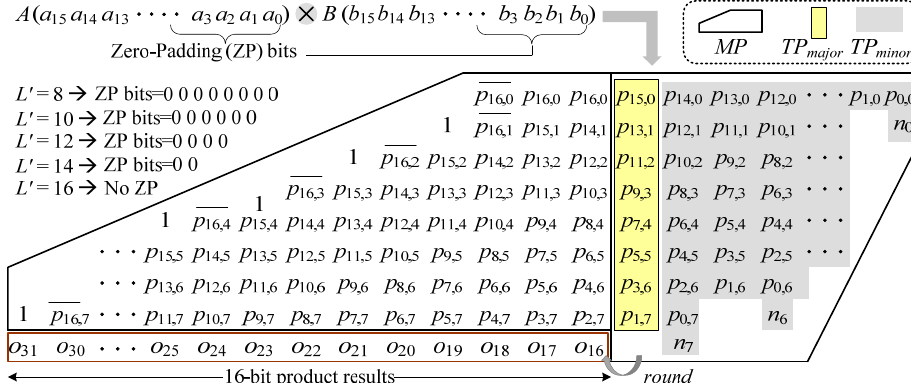
Figure 1. Partial product ( P.P. ) array structure for a 16-bit full-width Booth multiplier with multiple 16-to-8-bit numerical ranges of input patterns.